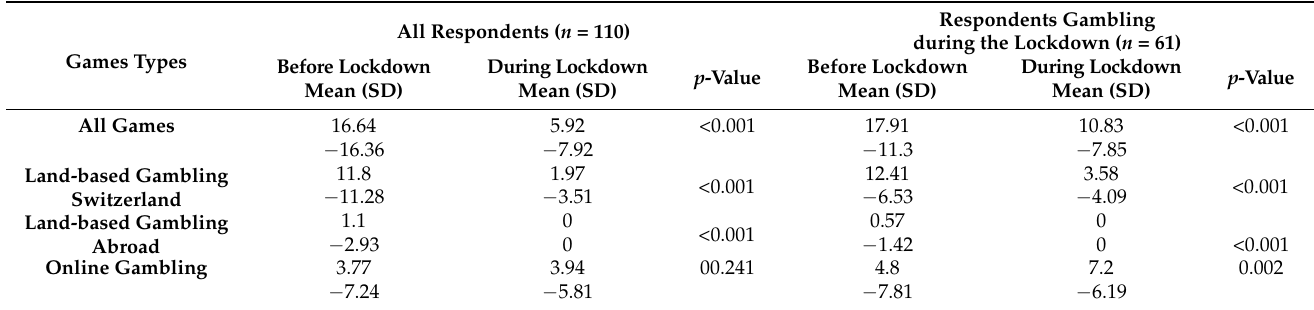
Table 3. Gambling intensity for different categories of gamblers before and during the lockdown.